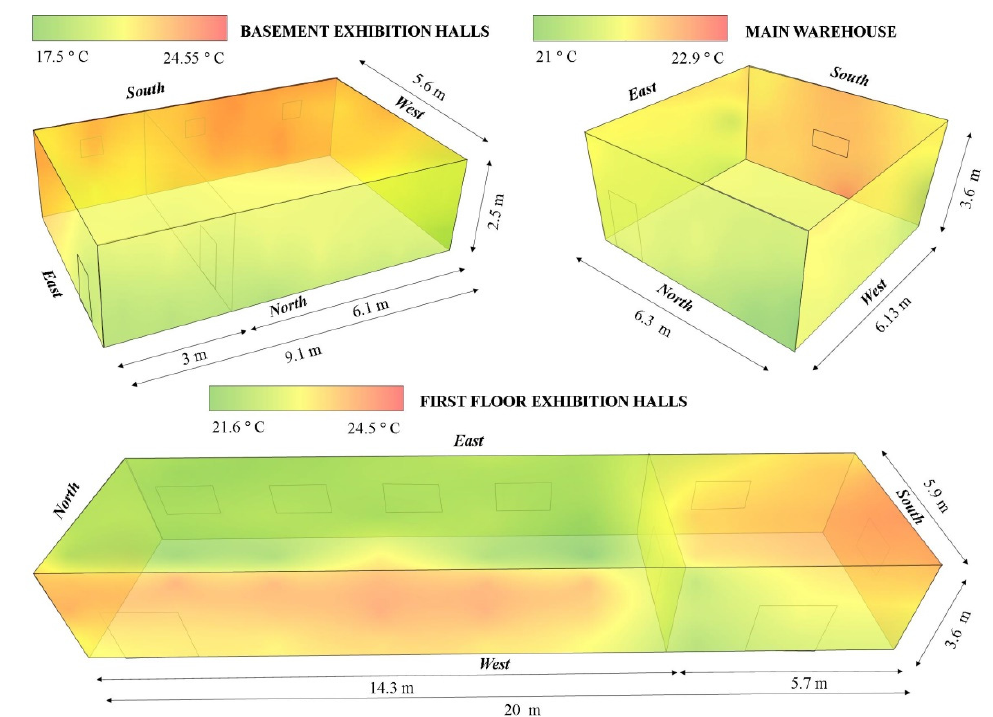
Figure 10. Distribution in space of temperature average values at the level of the walls of the analysed halls .